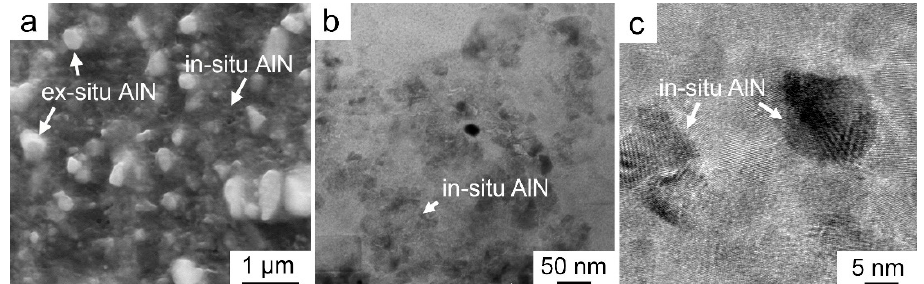
Figure 2. Microstructures of the 8.2AlN (in+ex) /Mg–8Al composite: ( a ) SEM image, showing the size of ex situ AlN particles; ( b , c ) TEM images, showing the size of in situ AlN particles.